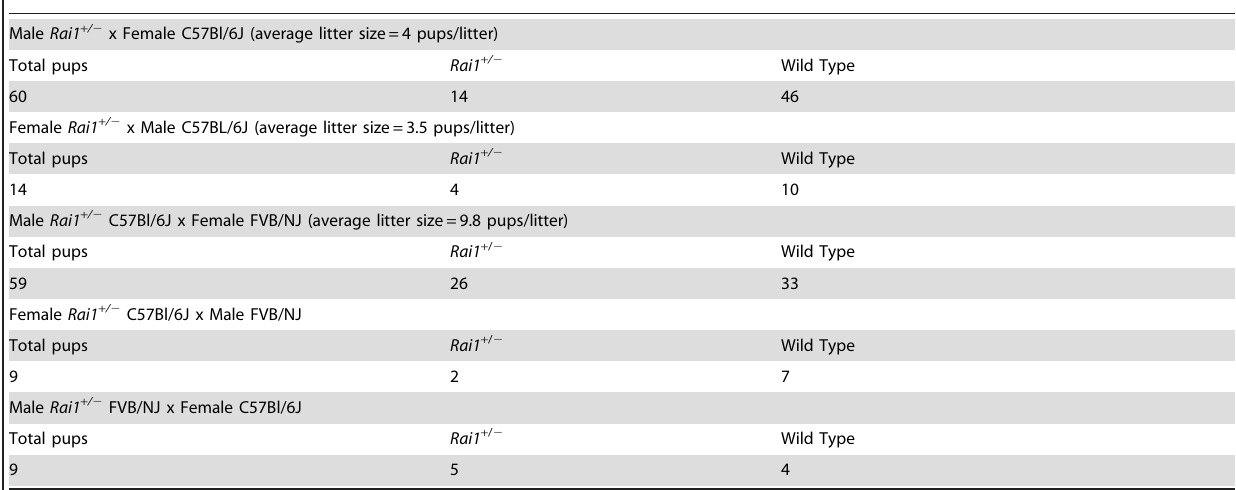
Table 1. Rai1 + / 2 breeding in the C57Bl/6J genetic